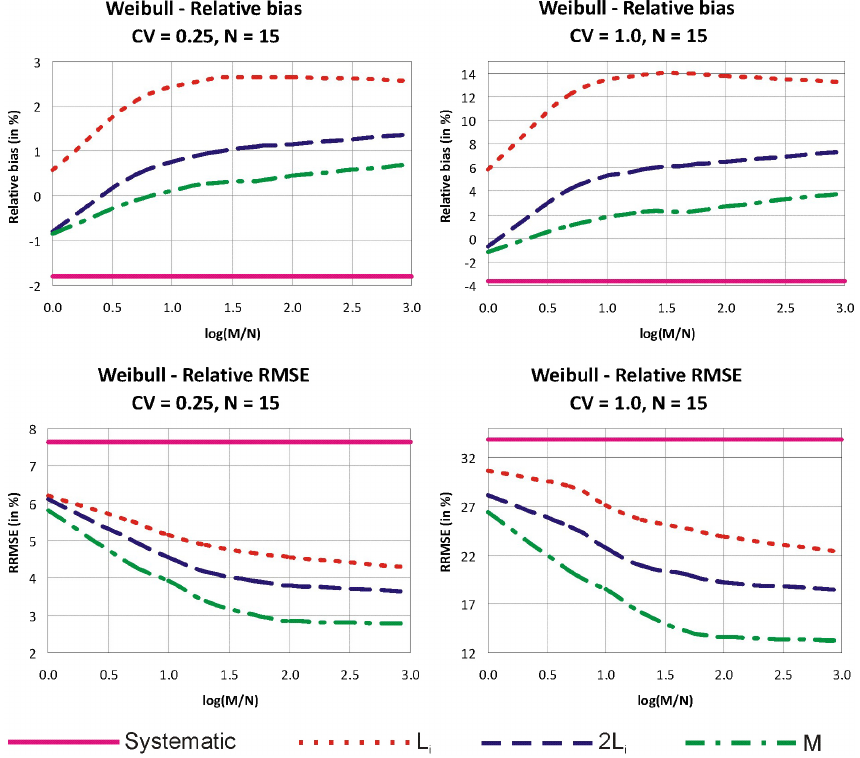
Figure 4. RB and RRMSE of ˆ X T = 100 as a function of gauge record length N and historic period M for ˆ M i = 0 , L i , 2 L i , M . Parent distribution Weibull with CV equal 0.25 and 1.0 and N = 15. Fitted distribution